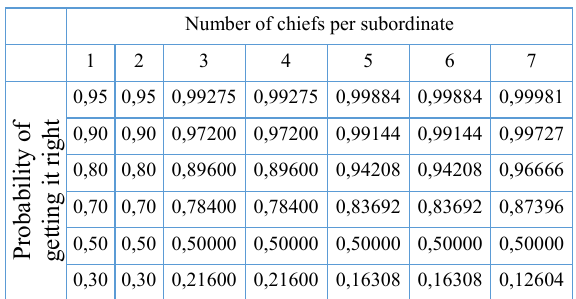
There is symmetry at p=0,5 in the discrete distribu– tion resulting from (4) and (5), as observed, e.g., for p=0,3 and p=0,7. In random decisions, randomness remains.